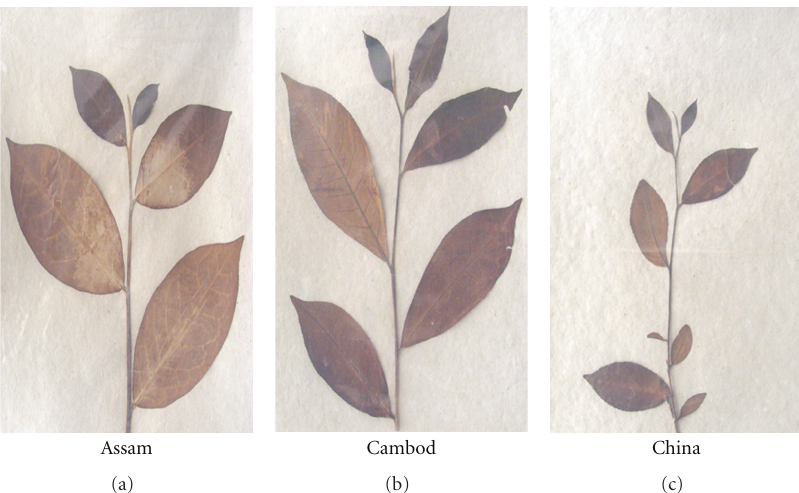
Figure 1: The typical shoots of three varieties (note that the photographs were taken from the herbarium of Tocklai Experimental